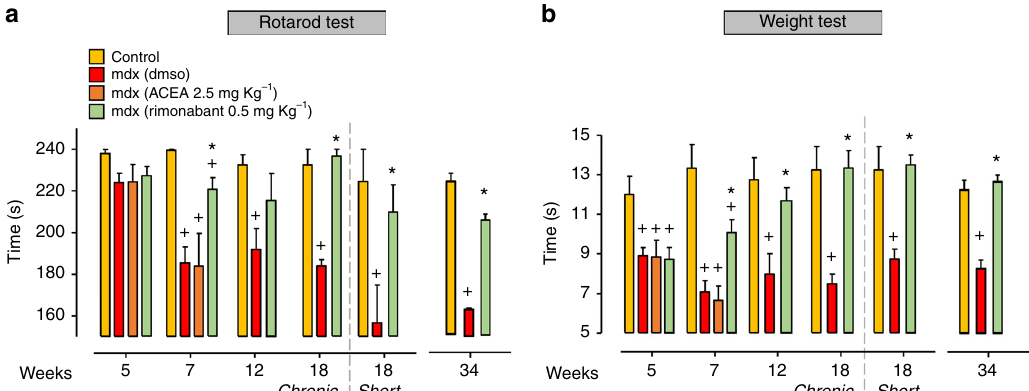
Fig. 6 Effect of rimonabant on locomotor activity of mdx mice treated. The muscle coordination and strength was measured in control ( n = 7) and mdx mice treated with vehicle (DMSO, n = 11), ACEA (2.5 mg Kg − 1 , n = 7), or rimonabant (0.5 mg Kg − 1 , n = 16 IP every other day) at the beginning of the treatment (5 weeks) and at 7, 12, and 18 (chronic) weeks. The treatment was repeated starting from week 16 until week 18 of age (18 short , control wt = 7; mdx + DMSO = 10; mdx + rimonabant = 10) or from week 32 until week 34 of age (control wt = 7; mdx + DMSO = 10; mdx + rimonabant = 10) by the rotarod ( a ) and weight ( b ) tests. Each bar is the mean ± SEM. + P ≤ 0.05 vs. control group, * P ≤ 0.05 vs. mdx vehicle group, determined by Student ’ s t test